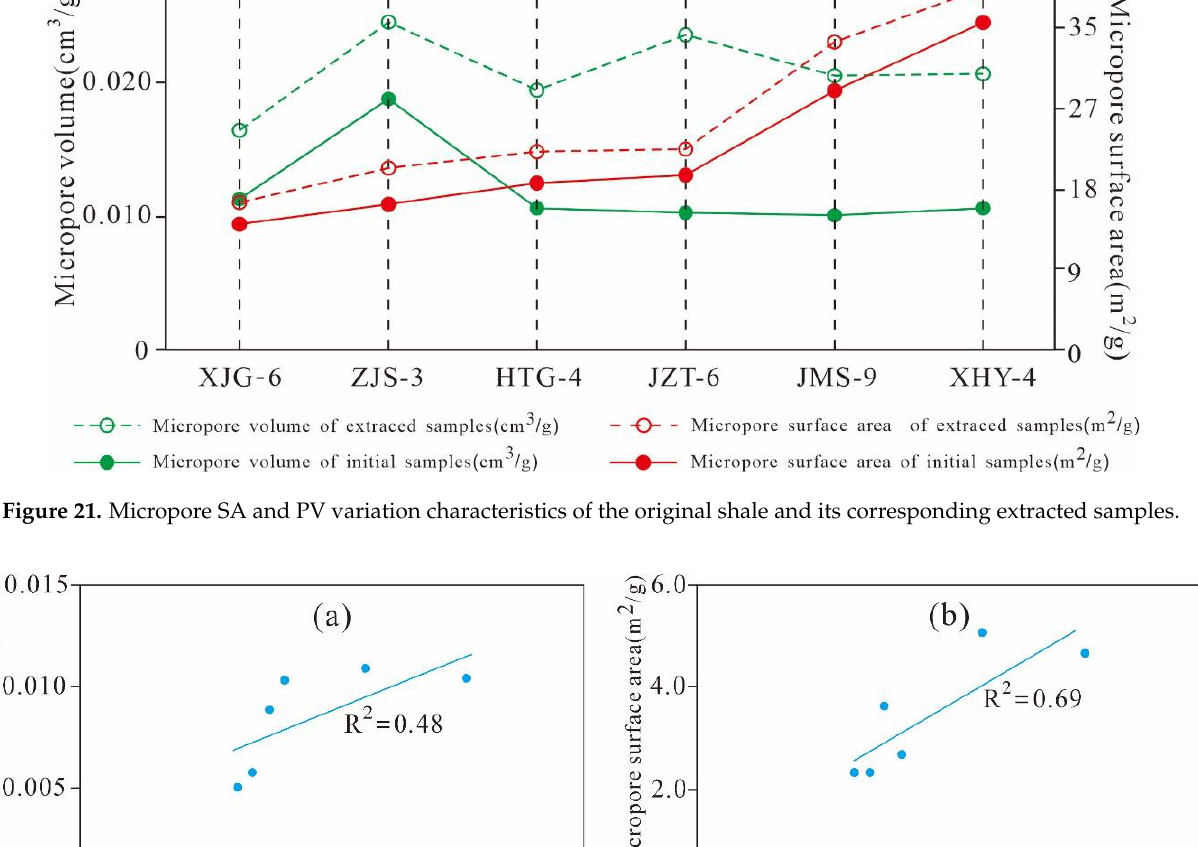
Figure 21. Micropore SA and PV variation characteristics of the original shale and its corresponding extracted samples.